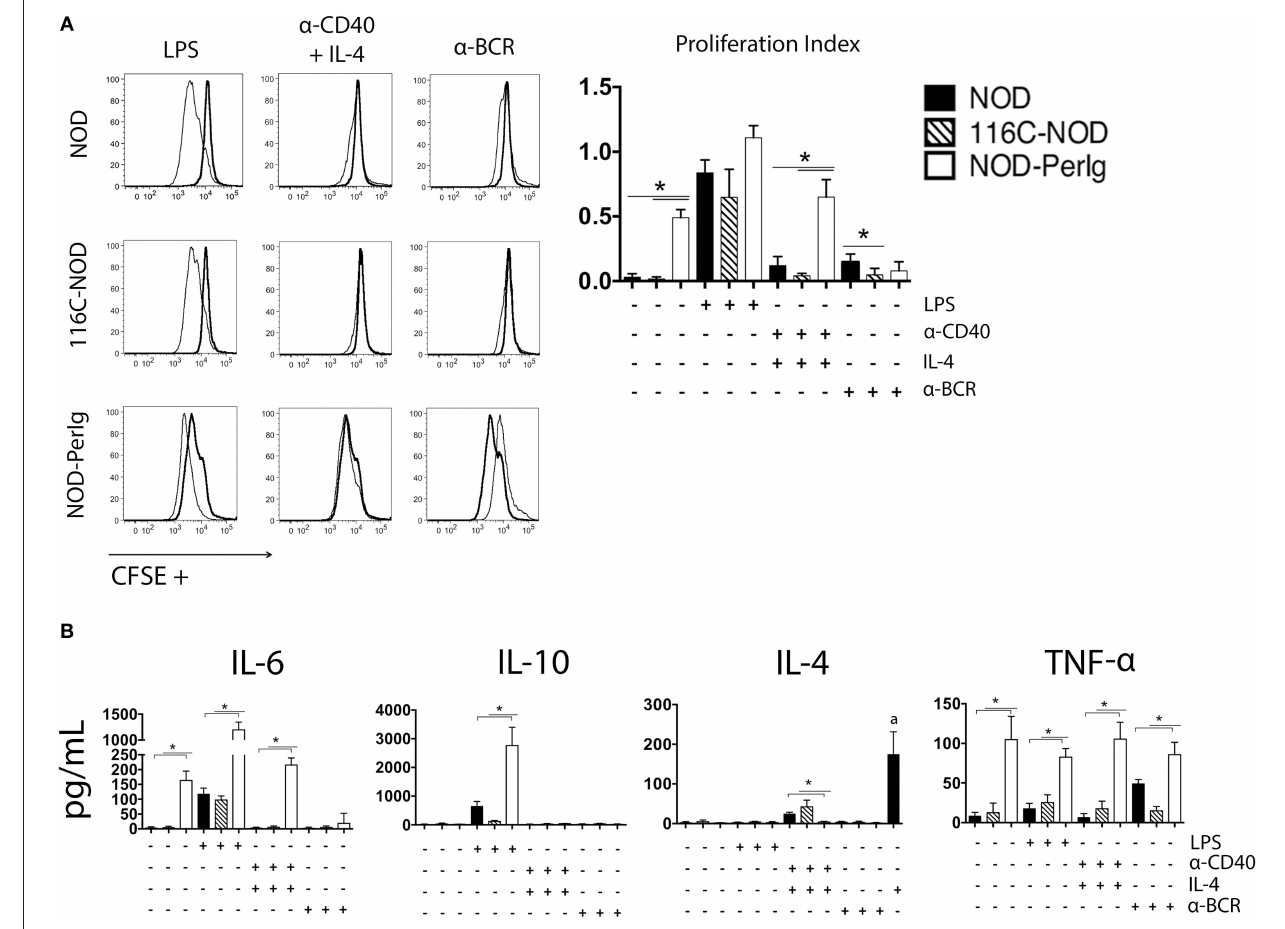
FIGURE 2 | B-lymphocyte proliferation assay. (A) CFSE analysis of proliferation responses of splenic B-lymphocytes from 6-week-old female NOD, 116C-NOD and NOD- PerIg mice ( n = 4 per group, with two replicates for each experimental condition). Splenic B-lymphocytes were purified, labeled with CFSE and cultured in the presence (narrow line) of LPS, anti-CD40 + IL-4, anti-BCR stimuli or without stimulus (bold line) for 48h. (B) IL-4, IL-6, TNF- α , and IL-10 cytokine concentrations were assessed in culture supernatants of purified B lymphocytes cultured in the same conditions as described above. (a) = Amount of IL-4 added to the culture media in absence of cells. Bars show the SD of the proliferation index or from the cytokine concentration values. Mann-Whitney U was used for analysis and statistically significant differences are shown as * P < 0.05.